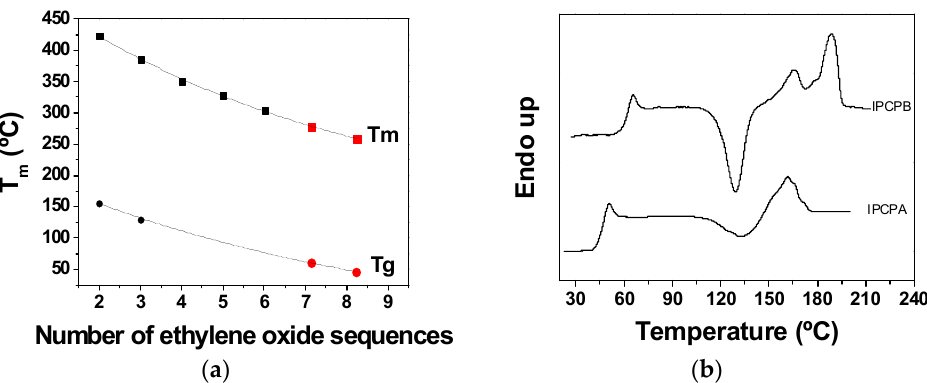
Figure 3. Thermal properties of poly(ether amides) as a function of the ethyleneoxide sequences: ( a ) glass transition temperatures of polymers TPCP-A and TPCP-B related to the number of ethyleneoxide sequences (T g and T m data for n = 2–6 was obtained from the literature, black symbols [20]; data from this work correspond to the number of ethyleneoxide sequences of 7.14 and 8.22, red symbols); ( b ) DSC of polymers IPCP-A and IPCP-B.